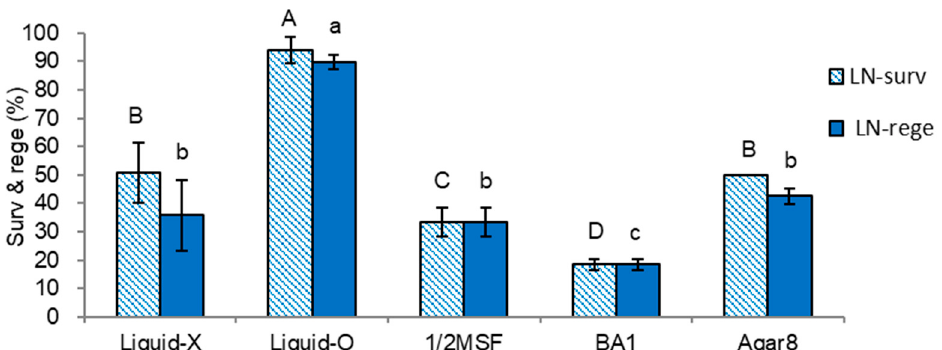
Figure 3. Effect of subculture medium and supplements on LN-survival (surv) and regeneration (rege) of P. yatabeanus shoot tips in regrowth steps of RM1(ammonium-free)-RM2-MSF. Liquid-X: MSF, gellan gum 3.0 g L − 1 , Liquid-X; Liquid-O: MSF, gellan gum 3.0 g L − 1 , Liquid-O; 1/2MSF: half-strength MSF, gellan gum 3.0 g L − 1 , Liquid-X; BA1: MSF, gellan gum